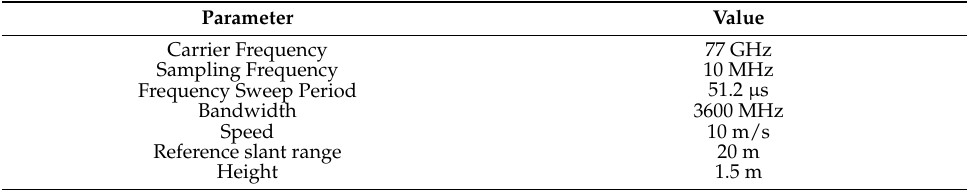
Figure 9. The ground scene for simulation. Table 2. Simulation